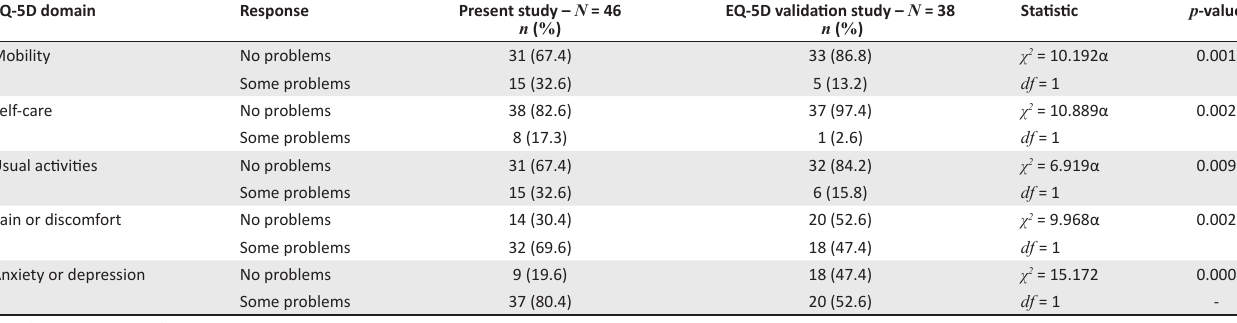
TABLE 3: Comparison of EQ-5D results from the present study and the EQ-5D Shona version validation study. EQ-5D domain